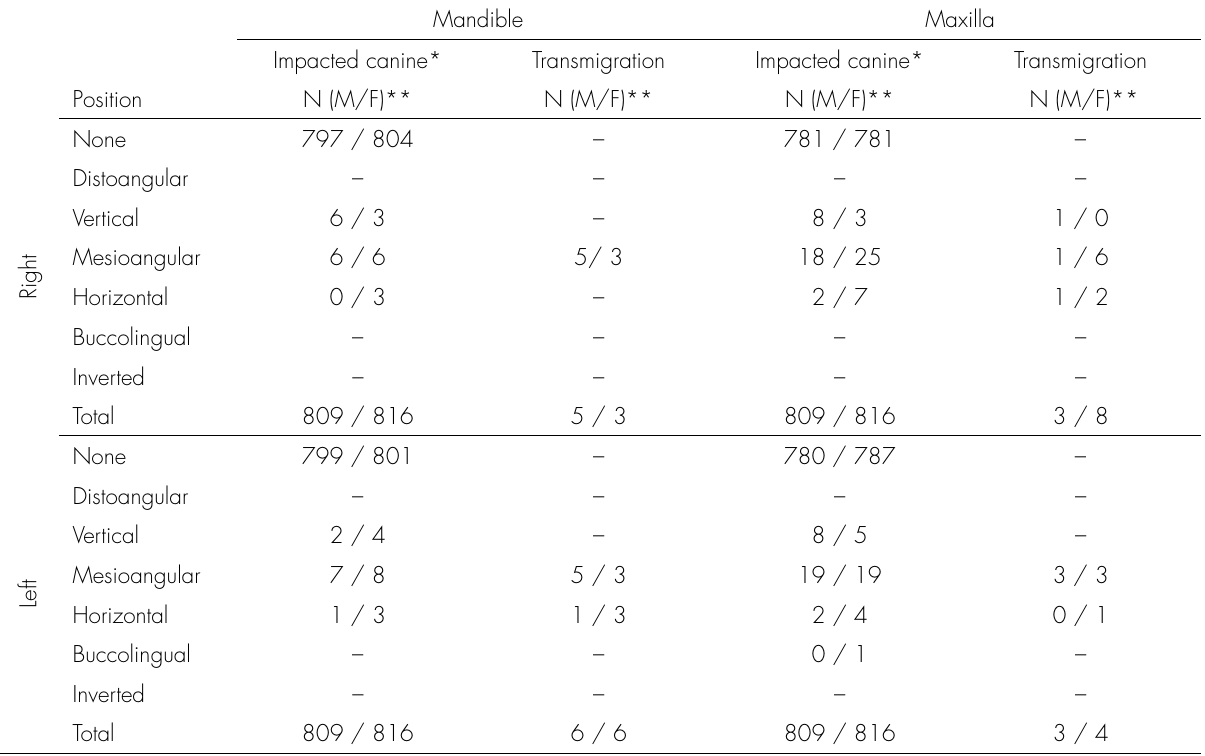
Table IV. The distribution of impacted and transmigrated canine teeth according to maxilla and mandible.